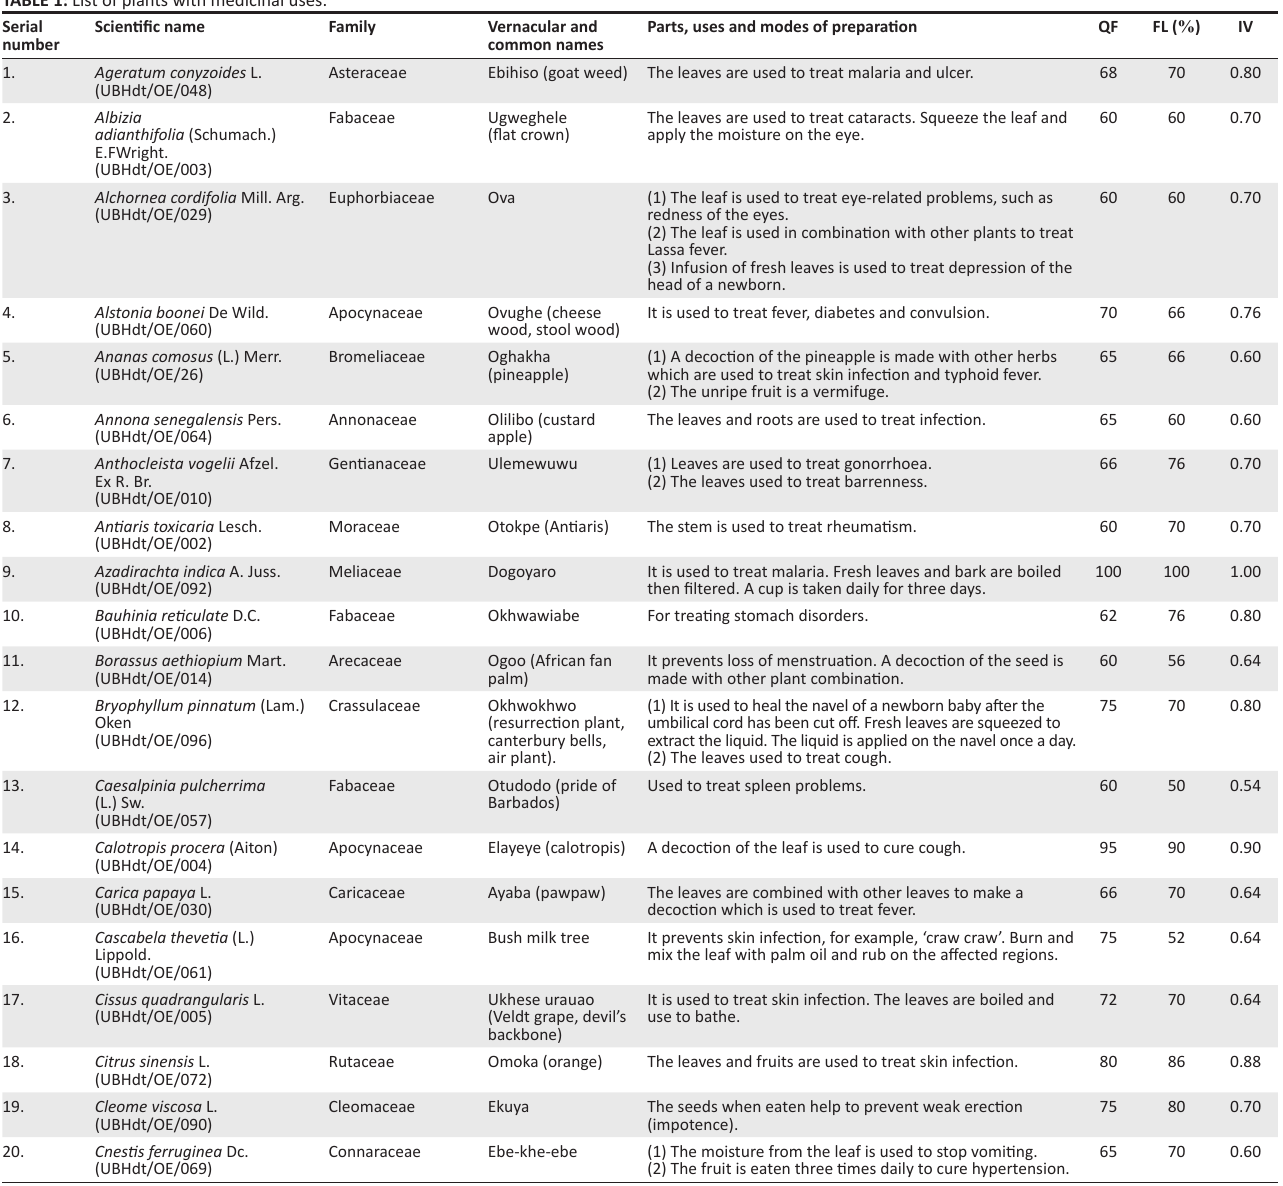
TABLE 1: List of plants with medicinal